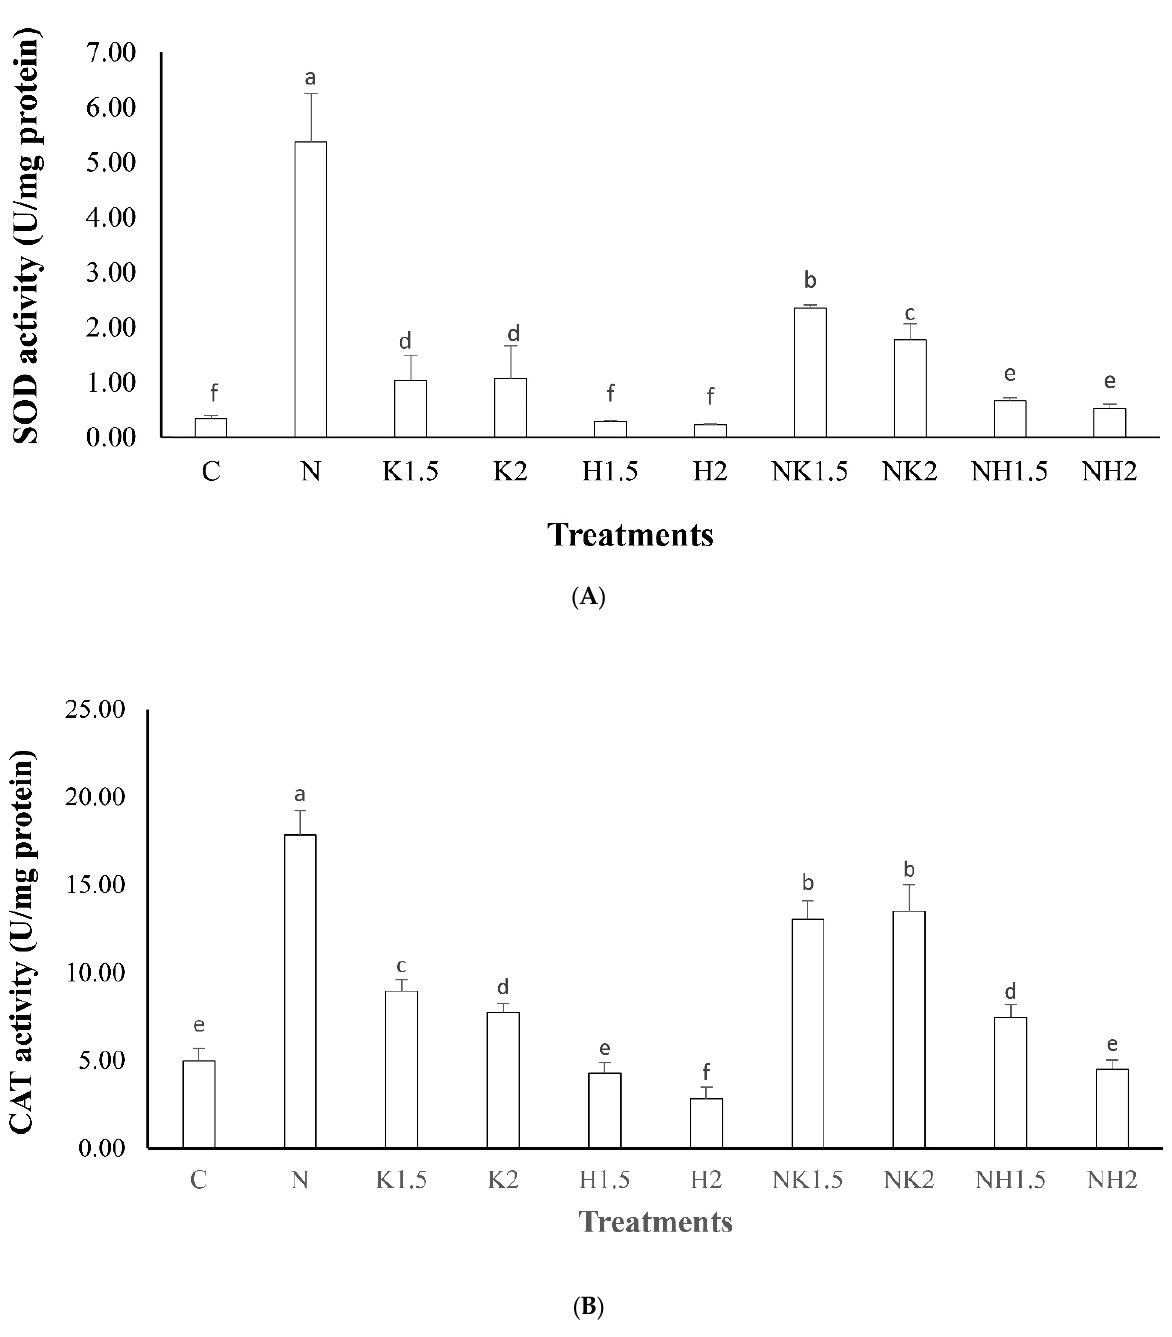
Figure 3. Effects of KCl and H 2 O 2 on the SOD and CAT activities of coral. Different letters indicate significant differences among groups ( p < 0.05). Values are expressed as means ± SDs (n = 30 colonies). ( A ): indicates SOD, ( B ): indicates CAT.